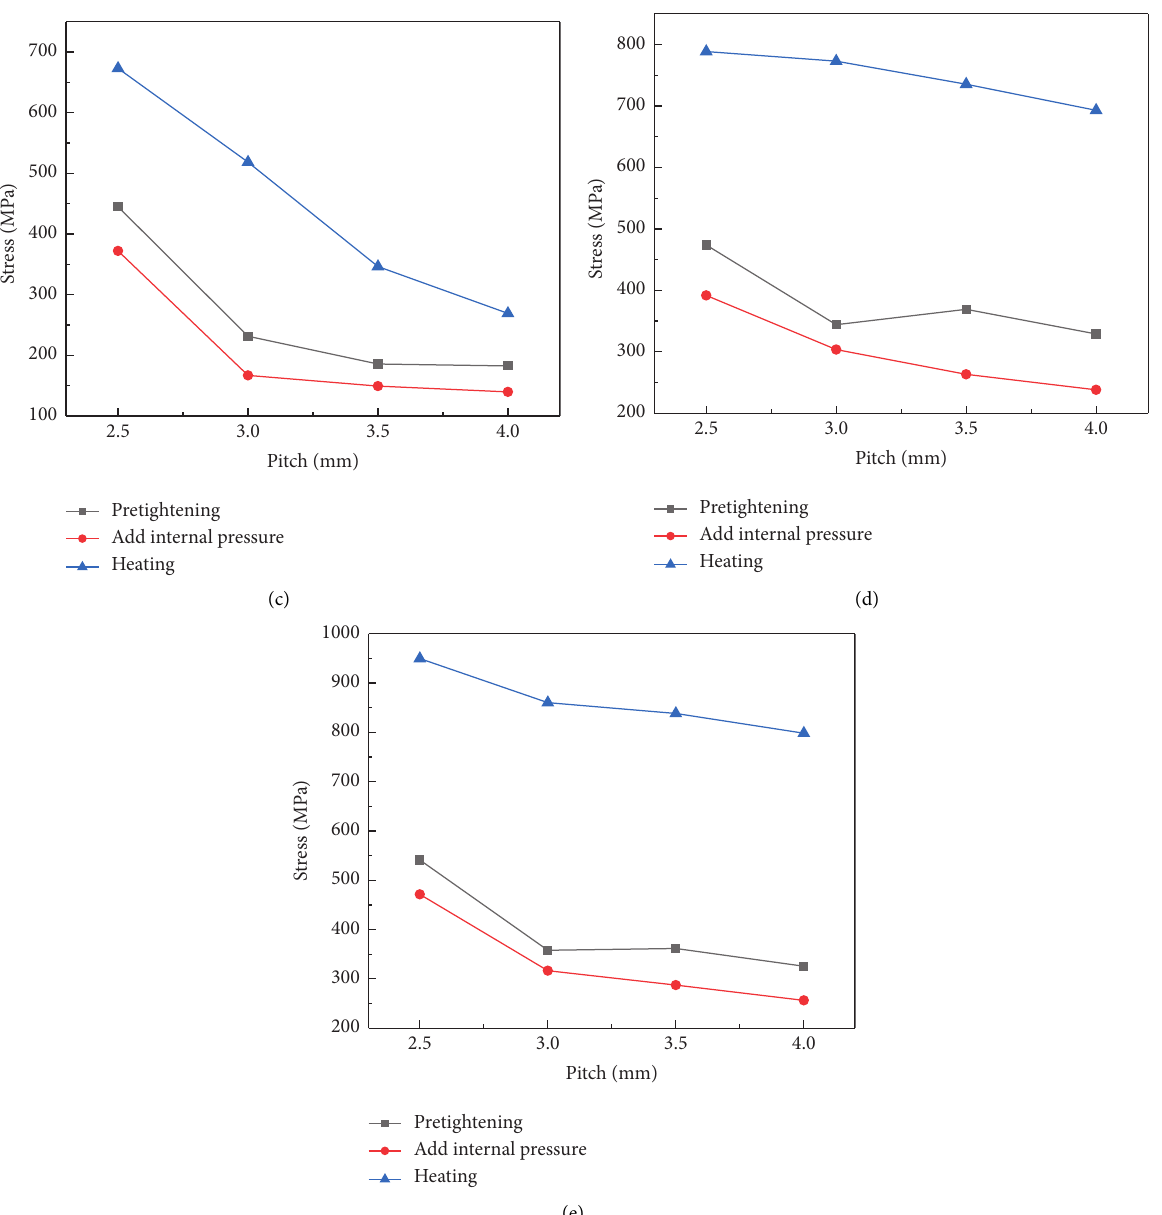
Figure 22: Contact pressure trends of various corrugations in different states in regard to pitch. (a) Corrugation A. (b) Corrugation B. (c) Corrugation C. (d) Corrugation D. (e) Corrugation